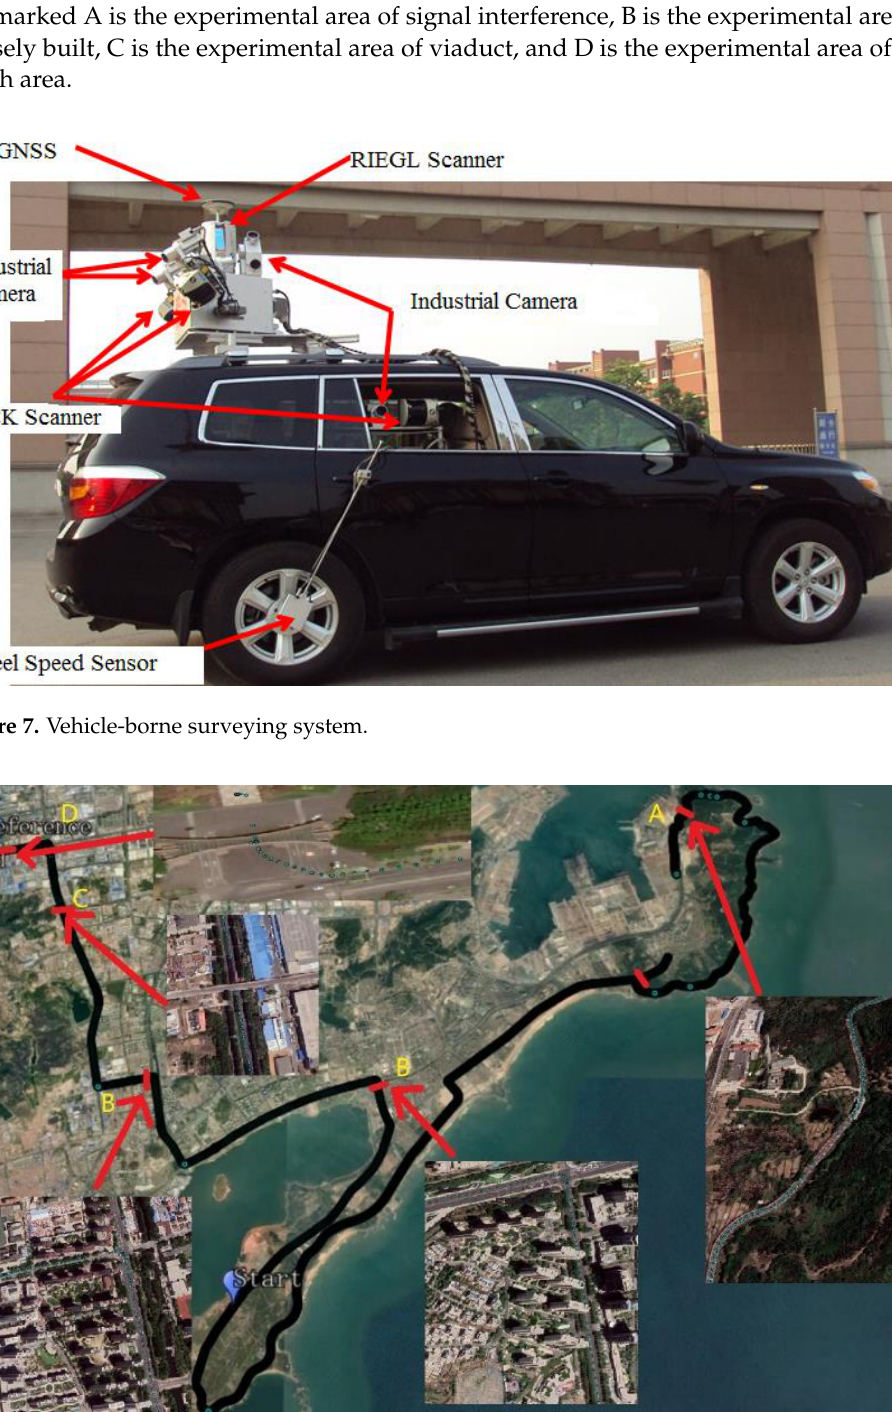
Figure 8. Experimental area and mobile trajectory.